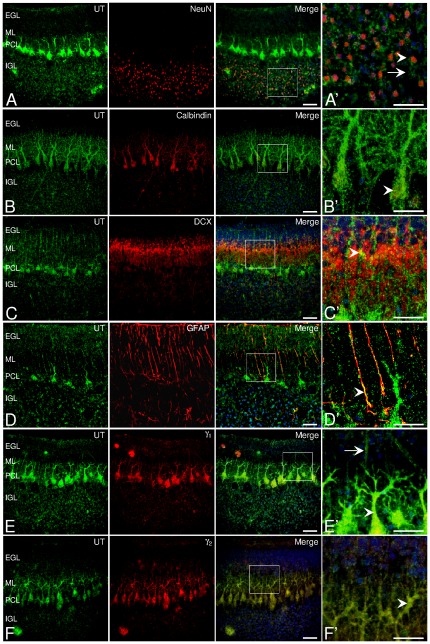
Co-localization of UT with γ subunits in neuron and glial components in rat cerebellum.(A, A′) Double-fluorescence staining for UT (green) and NeuN (red) showing the presence of UT in both mature (arrowhead, merge, A′) and unidentified cells (arrows, merge, A′) in the IGL. (B) Co-staining of UT and the marker of Purkinje cells, calbindin (red), in Purkinje cell soma and dendrites (arrowhead, B′). (C) Staining for UT and the marker of migrating neuroblasts doublecortin DCX (red) depicting a diffuse labeling in the ML. (C′) UT immunopositive fibers contiguous to DCX-expressing migrating granule cells (merge, yellow, arrowhead). (D, D′) Staining for UT and GFAP (red) in glial fibers (merge, yellow, arrowhead) of the ML. (E, F) Distribution of UT and the γ1 (E) and γ2 (F) GABAAR subunits (red), in Purkinje cells (merge, arrowhead) and few extents of glia (merge, arrow) in the ML and IGL. Nuclei (blue) were counterstained with DAPI. Scale bars, 50 µm (A–F); 20 µm (A′–F′). EGL, external granule cell layer; IGL, internal granule cell layer; ML, molecular layer; PCL, Purkinje cell layer. (A′–F′) images of digitally zoomed regions corresponding to the white boxes in A–F.